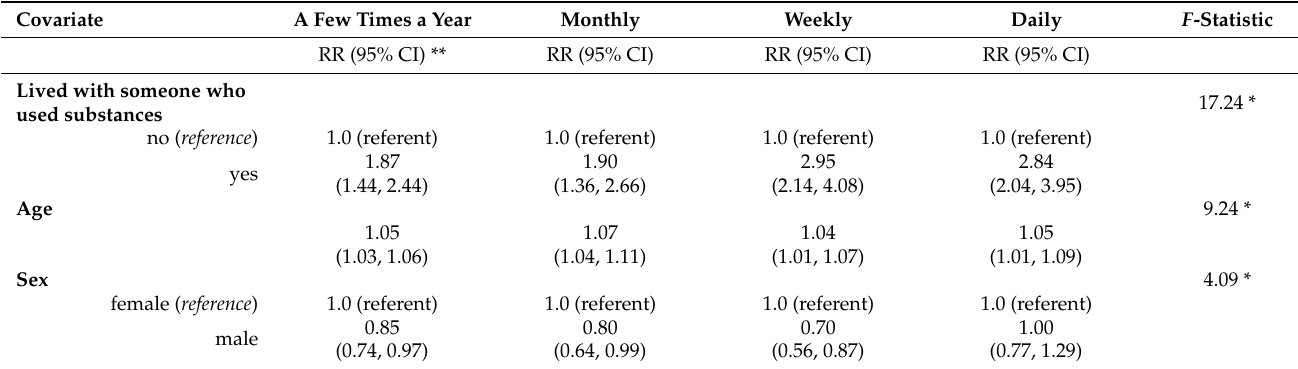
Table 4. Multinomial regression models for the association between having ever resided with someone who used substances and the frequency of children’s anxiety (referent = never experienced anxiety)—2019 National Health Interview Survey (n =